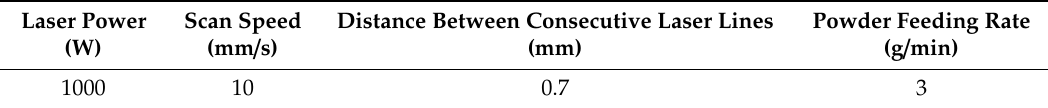
Table 3. Fabrication control